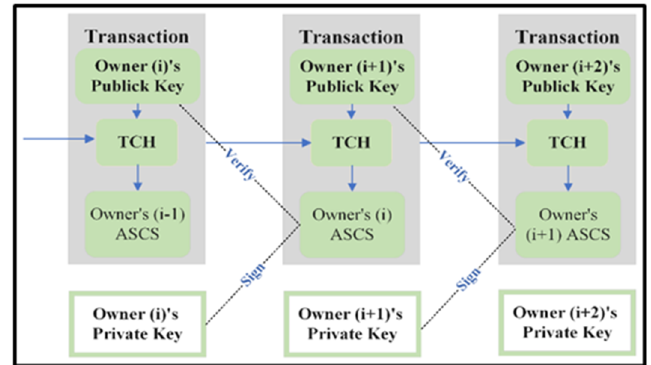
Figure 7. The Huang et al. (2019) RCB signature chain.